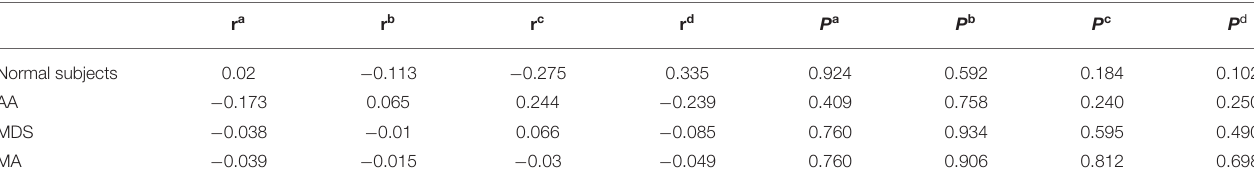
TABLE 3 | Correlation analysis between the area of RBCs and standard red blood cell indices. r a r